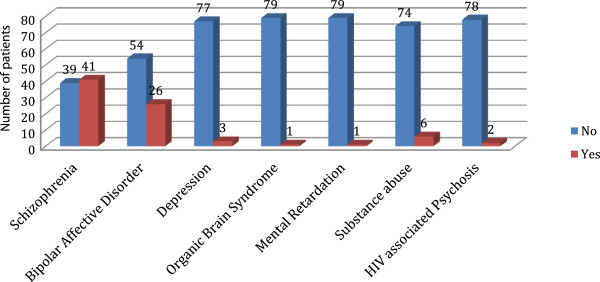
Distribution of psychiatric illnesses for participants with low serum vitamin B12 levels. The majority of participants with low serum vitamin B12 had a diagnosis of schizophrenia (41patients). Fifty four participants who had a diagnosis of Bipolar affective disorder did not have low serum vitamin B12 levels.